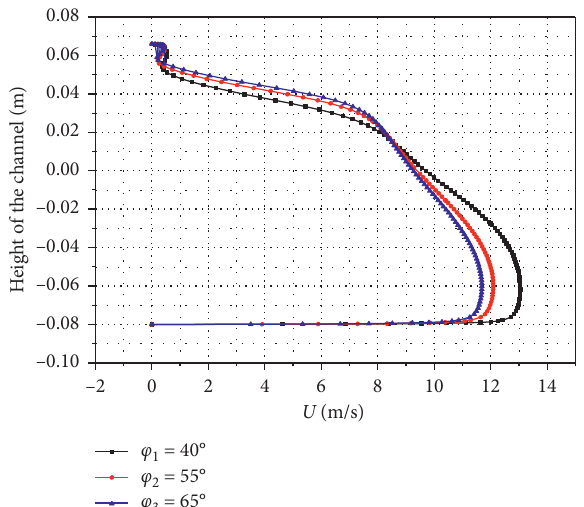
Figure 6: Axial velocity profiles upstream of the first baffle at x � 0.159m for different values of inclination angles: φ 1 � 40 ° ; φ 2 � 55 ° ; φ 3 � 65 ° .